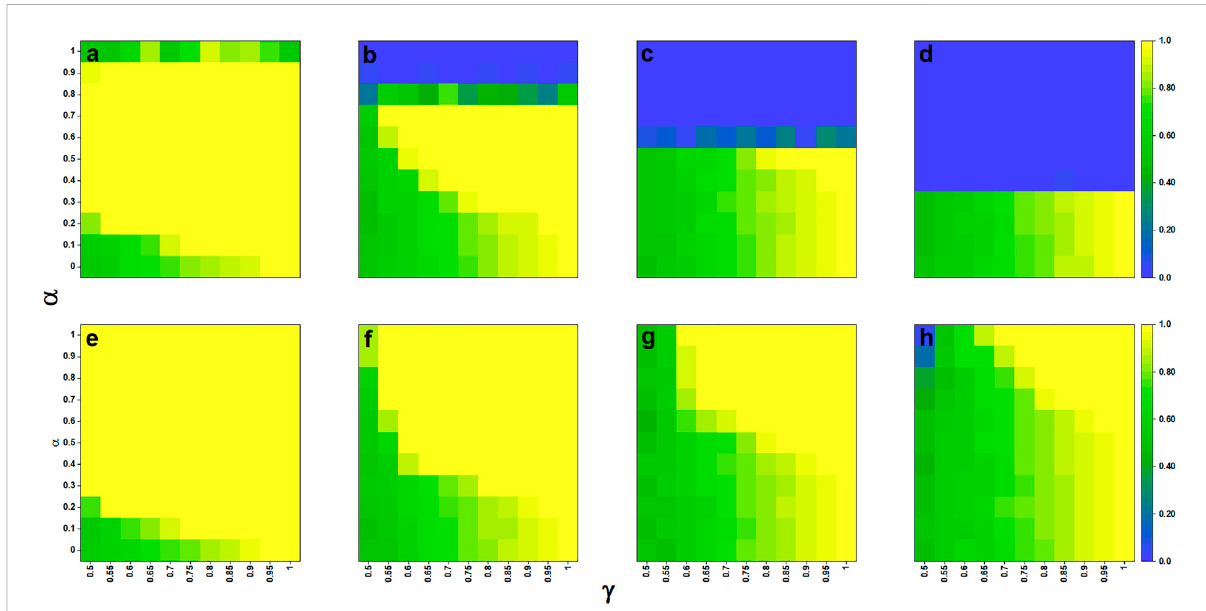
FIGURE 5 α − γ phase graphs, the in fl uence of conformity fraction ( α ), and herd immunity threshold ( γ ) on the vaccination coverage. The corresponding value of each point in the fi gure is the vaccination coverage when the evolution reaches the 100th time step. C H is fi xed at 1. Other parameters correspondingtoeachimageareasfollows: (A) V 0 =0.2and C V =0.1; (B) V 0 =0.2and C V =0.3; (C) V 0 =0.2and C V =0.5; (D) V 0 =0.2and C V =0.7; (E) V